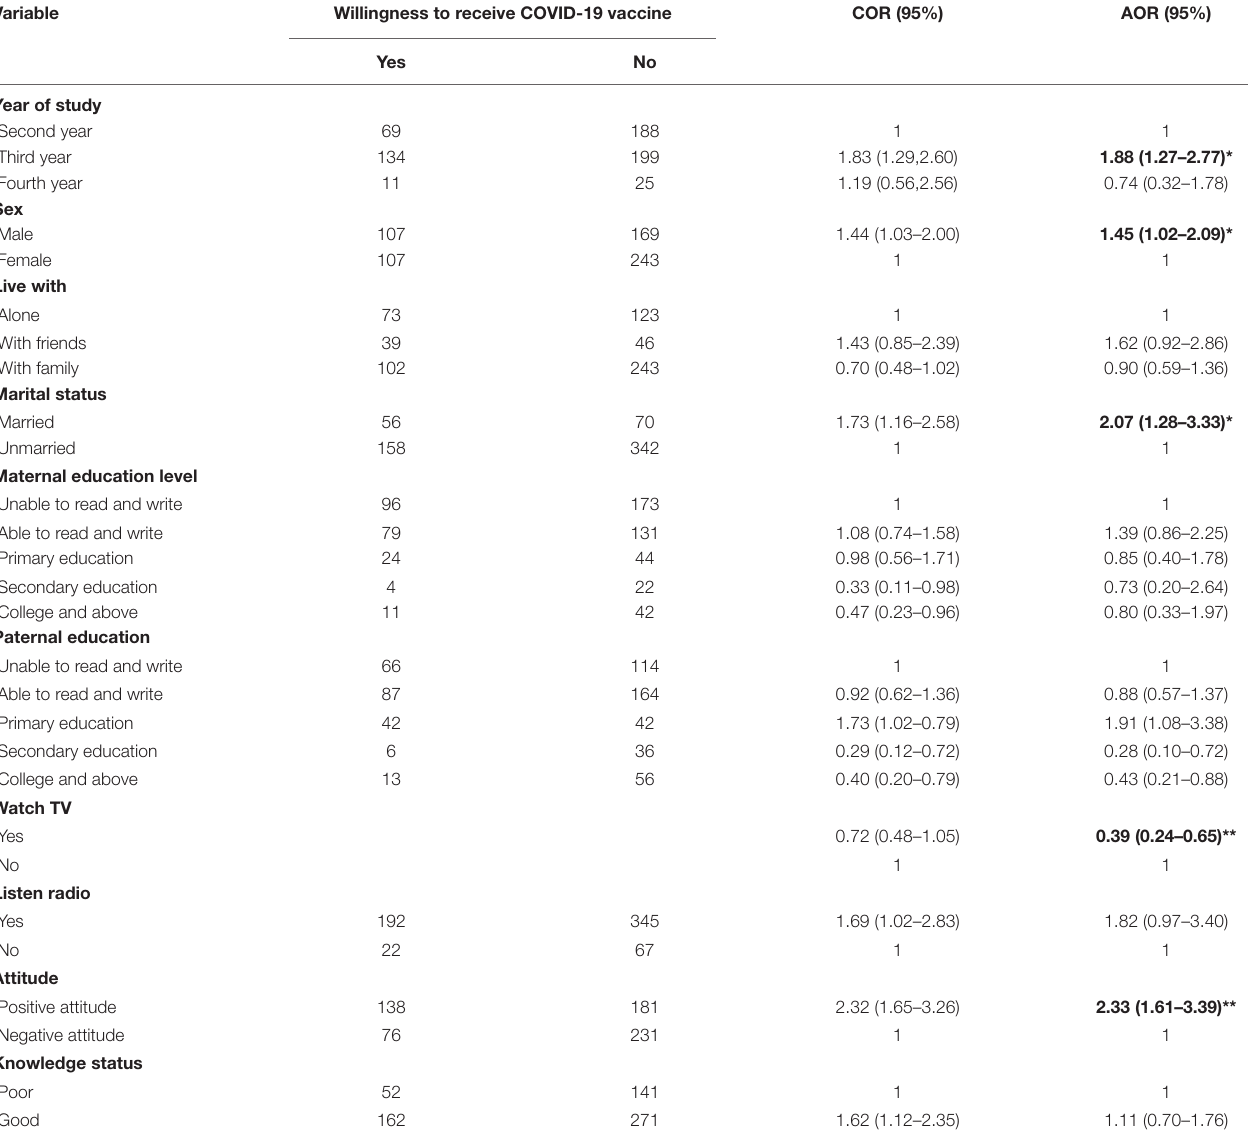
TABLE 3 | Bivariable and multivariable analysis of factors associated with willingness to receive the COVID-19 vaccine among college students in Gondar city, Northwest Ethiopia, 2021 ( n = 626).